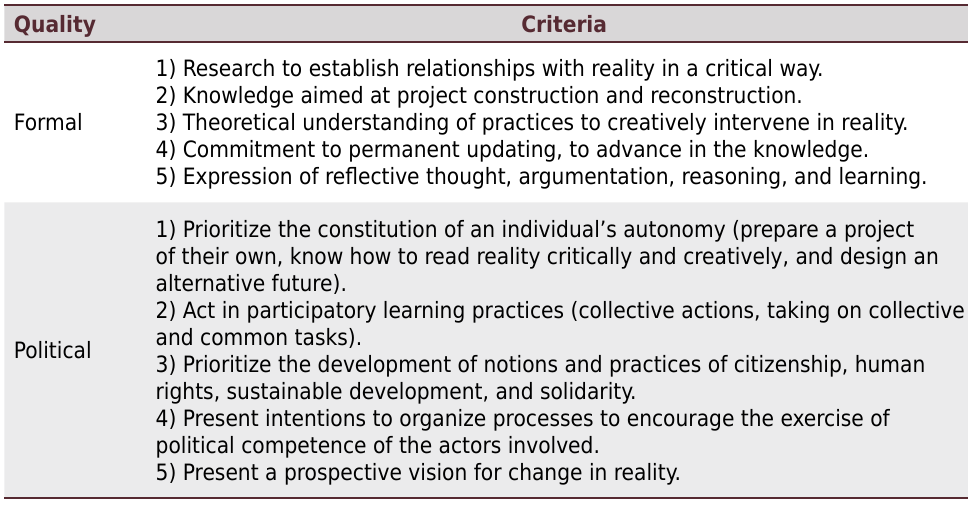
Table 2. Formal quality criteria and education policy to serve as a basis for evaluating students in educational processes subsidized by the Alternative Methodology of Problem-Cases (AMPC), as adapted from Demo